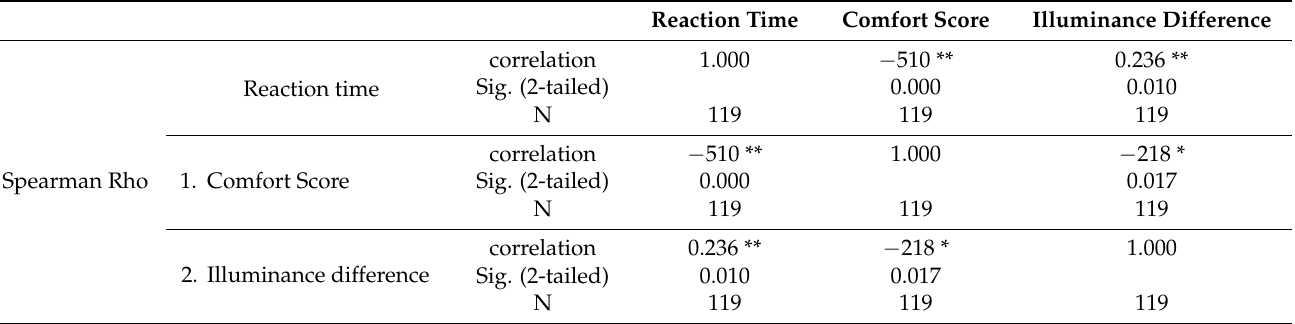
Table 6. Correlation between reaction time and comfort under increasing illuminance.